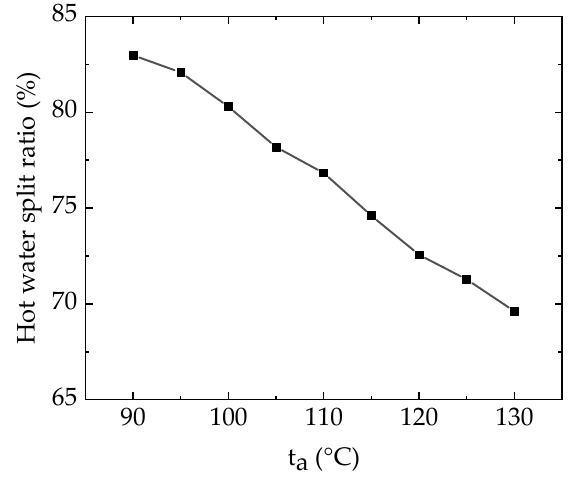
Figure 14. The hot water split ratio in SFD-ORC at the optimal operating conditions.